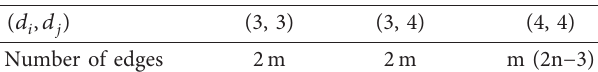
Table 1: Edge partition of TUC vertices of each